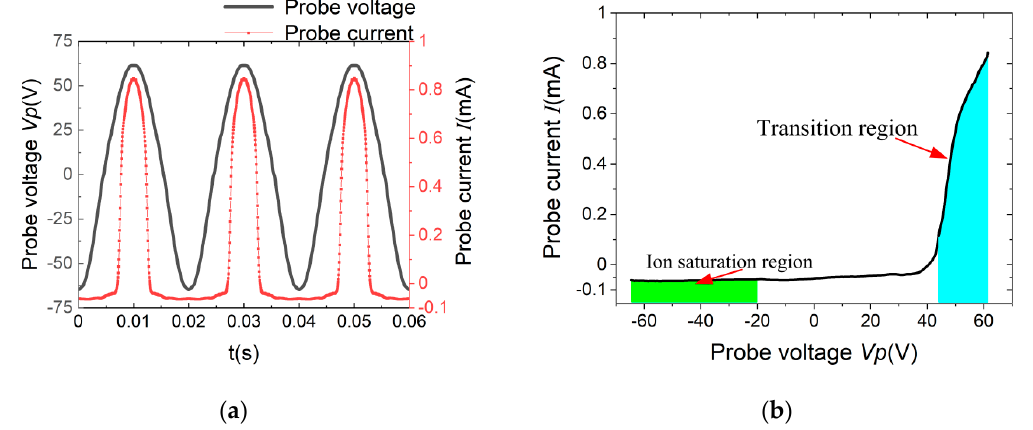
Figure 4. The I–V curve of the clean Langmuir probe ( a ) the voltage and current curve, ( b ) I–V curve.